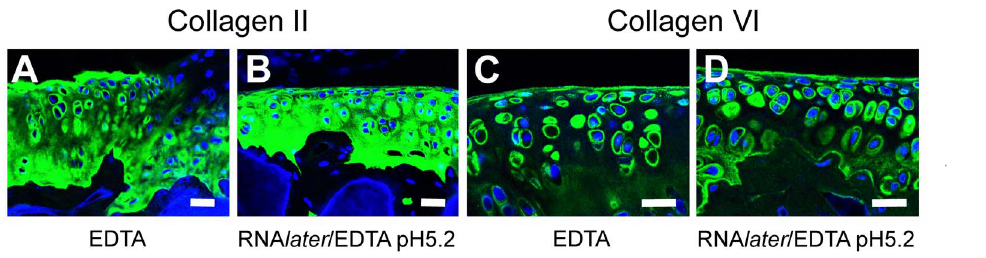
Figure 5. Fluorescent immunohistochemistry of articular cartilage. Collagen II (A, B) and collagen VI (C, D) protein localization was unaffected by RNA later /EDTA, pH 5.2 decalcification (B, D) compared to conventional EDTA decalcification (A, C). Using both methods collagen II can be seen in both the pericellular and extracellular matrix, while collagen VI is predominantly localized to the pericellular matrix. DAPI was used as a nuclear stain. Scale bars=50 m m.